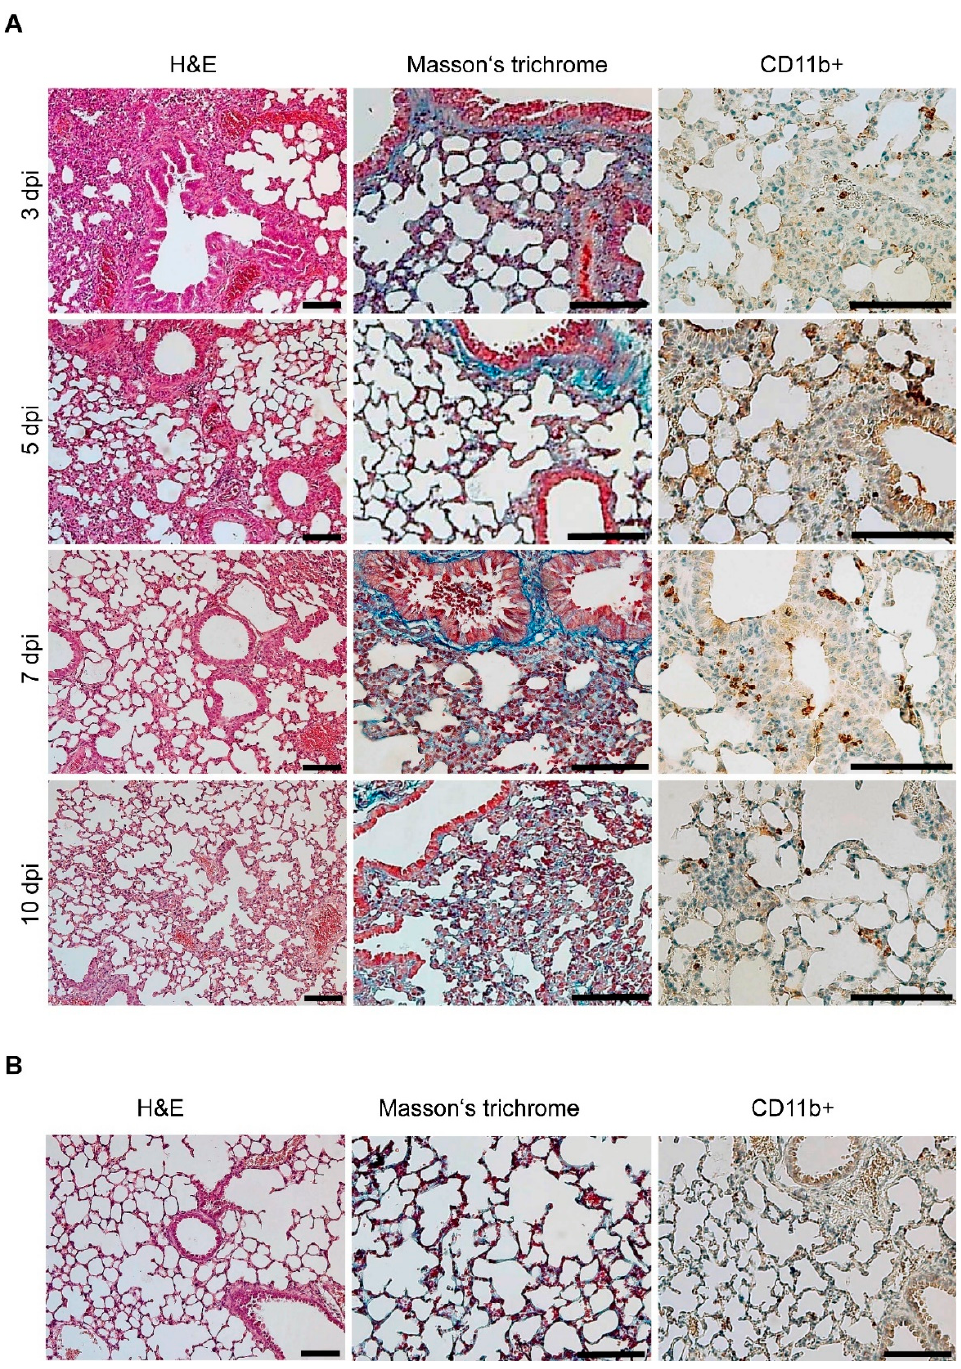
Figure 4. Lung tissue histopathological appearance of a mouse infected with a low dose of the clinical isolate. ( A ) Hematoxylin and eosin (H&E), Masson’s trichrome, and macrophage (CD11b+, brown) staining was performed on the lung tissue sections from a representative A/JOlaHsd mouse infected with the L. pneumophila Sg 1, ST 62, MAb Knoxville clinical isolate at a dose of 10 4 CFU i.n. Note that the blue structures (Masson’s trichrome) were referred to as an outcome of normal connective tissue septa compression due to the inflammatory reaction. ( B ) Lung sections obtained from noninfected A/JOlaHsd mice (noninfected control). Scale bars: 100 μ m. The high-dose challenge of the A/JOlaHsd mice revealed more severe pathological changes (Figure 5). The high legionellae dose resulted in a multifocal to coalescing reac- tion characterized by mixed inflammatory infiltration at 3 dpi. At 5 dpi, the lung condition